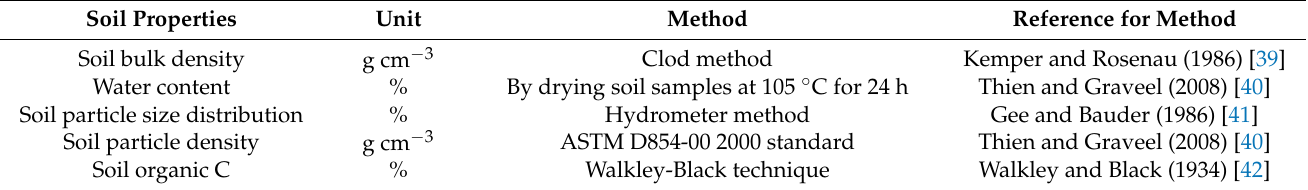
Table 1. Methods of analyzing soil properties and